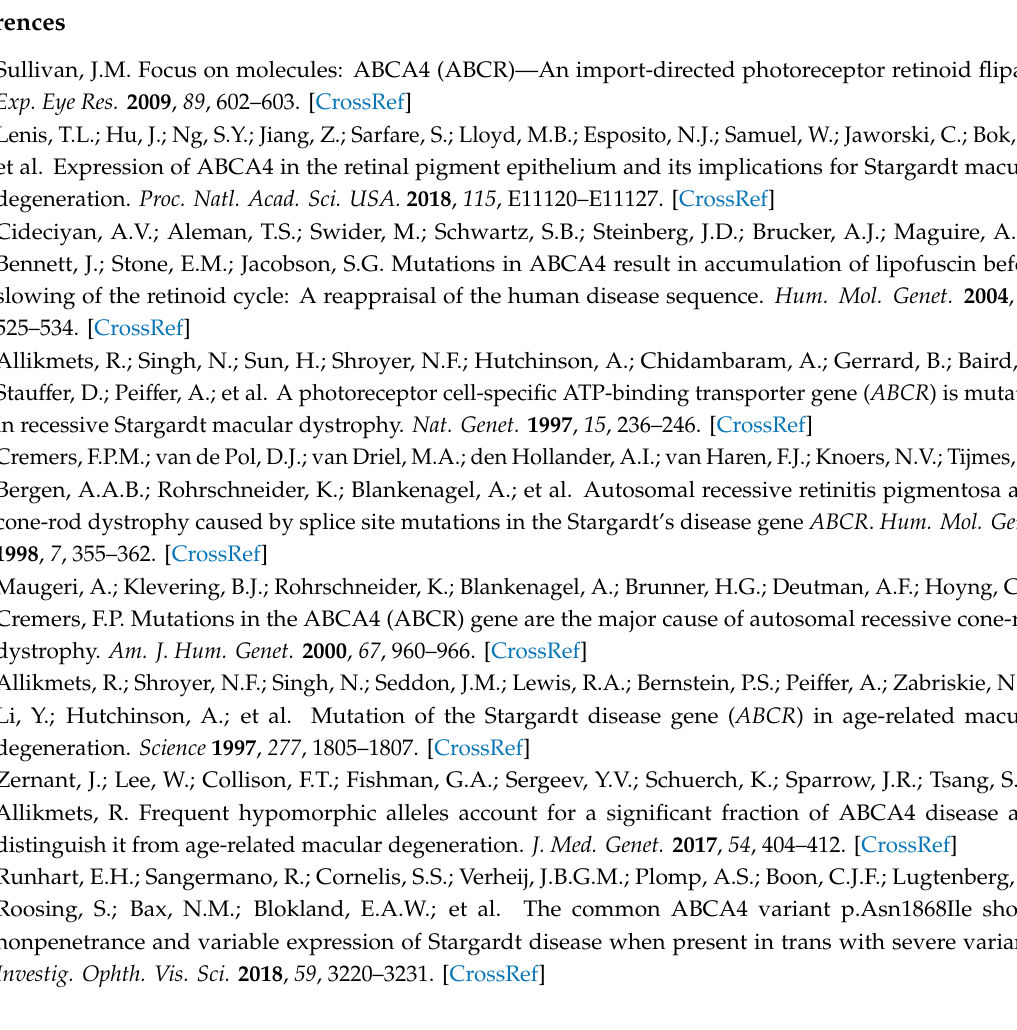
Figure S1: Family pedigrees, Table S2: Clinical and genetic characteristics of all